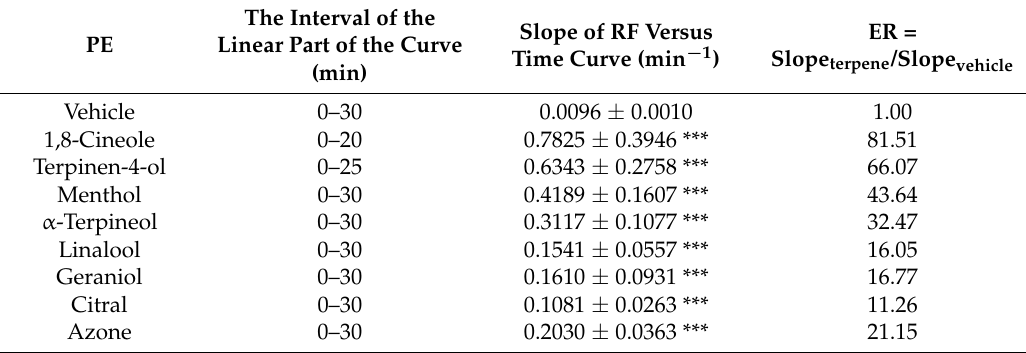
Table 3. The ER values of different oxygen-containing terpenes calculated by SER kinetics with the use of the vehicle of isopropanol-PBS (1:1, v / v ) ( n = 5). The Interval of the Slope of RF Versus PE Linear Part of the Curve Time Curve (min − 1 ) (min)